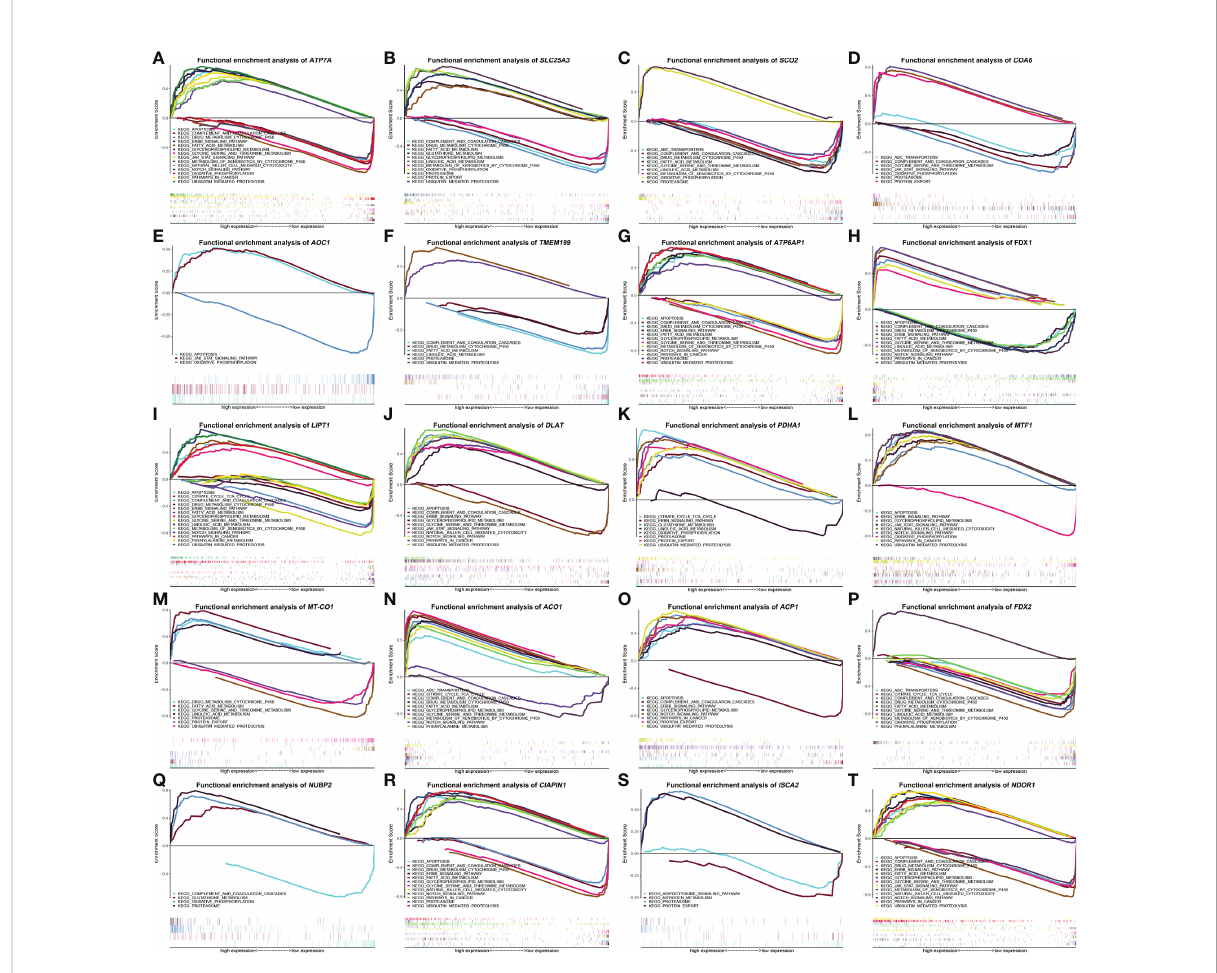
FIGURE 6 The enrichment plots of screened cuproptosis-related gene expression levels in hepatocellular carcinoma (HCC) patients from Gene Set Enrichment Analysis (GSEA). Functional enrichment analysis of cuproptosis-related genes expression in TCGA HCCs, including ATP7A (A) , SLC25A3 (B) , SCO2 (C) , COA6 (D) , AOC1 (E) , TMEM199 (F) , ATP6AP1 (G) , FDX1 (H) , LIPT1 (I) , DLAT (J) , PDHA1 (K) , MTF1 (L) , MT- CO1 (M) , ACO1 (N) , ACP1 (O) , FDX2 (P) , NUBP2 (Q) , CIAPIN1 (R) , ISCA2 (S) , and NDOR1 (T) . (ACO1, aconitase 1; ACP1, acid phosphatase 1; AOC1, amine oxidase copper